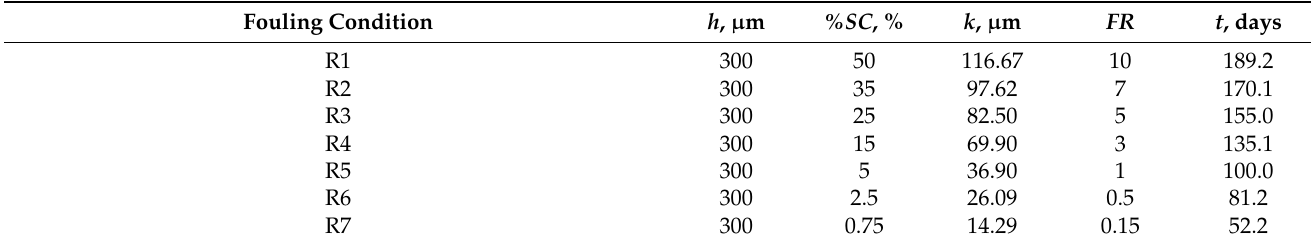
Table 2. Analyzed fouling